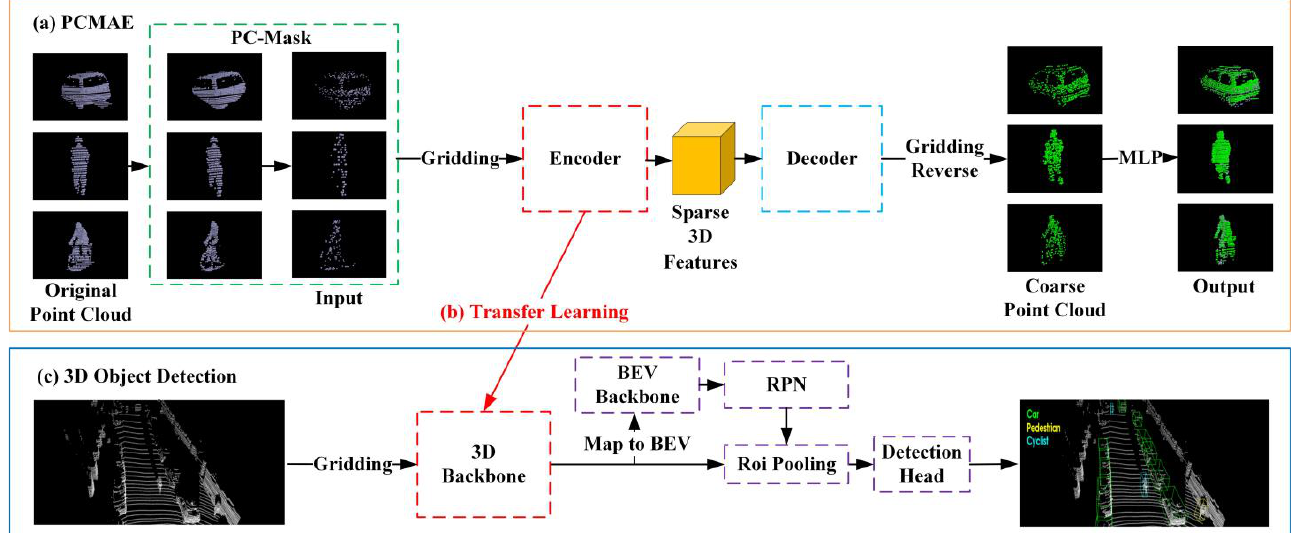
Figure 2. ( a ) PCMAE structure. ( b ) Shared pre-trained model weights through transfer learning. ( c ) 3D object detection model.